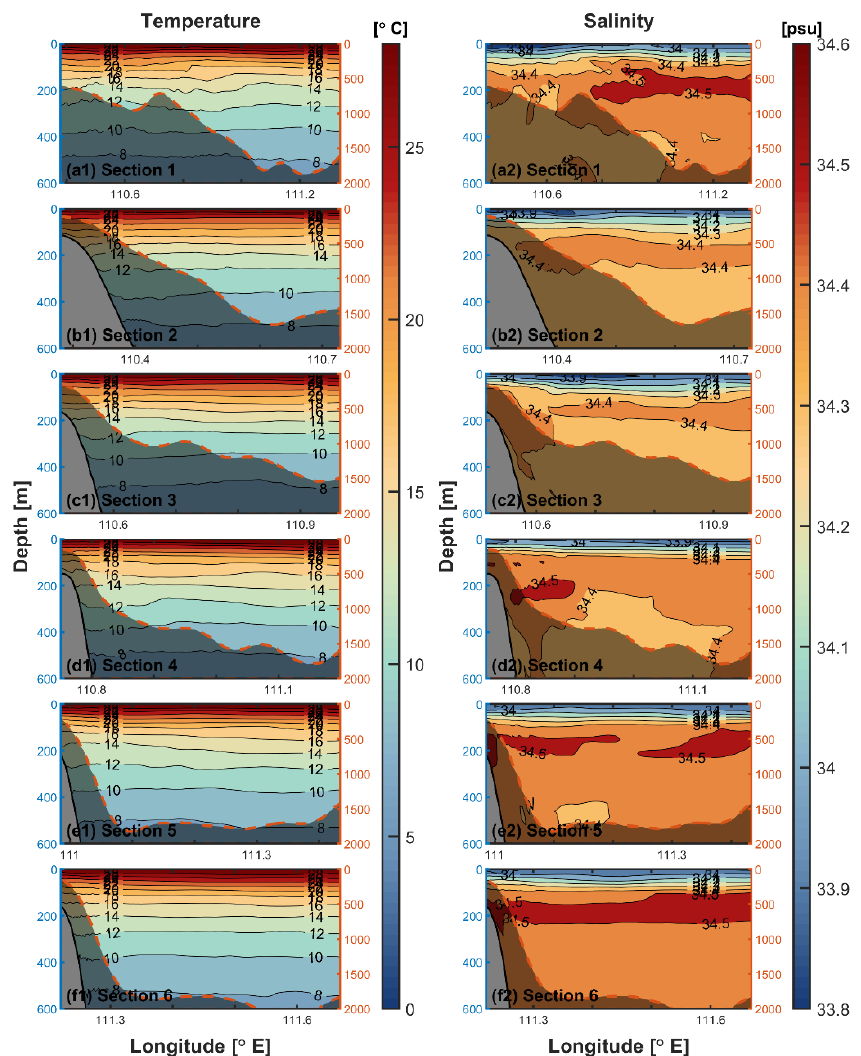
Figure 7. Distribution of temperature ( left ) and salinity ( right ) in Sections 1–6 of Figure 1c at peak flood of the spring tide (UTC 2020-07-19 07:00). The colors and contours indicate the magnitude of each parameter, whereas the overlaying grey shadow shows the bathymetry. The blue label indicates the water depth corresponding to the underlaying color and contour plot. The orange label indicates the water depth corresponding to the overlaying shadow plot.